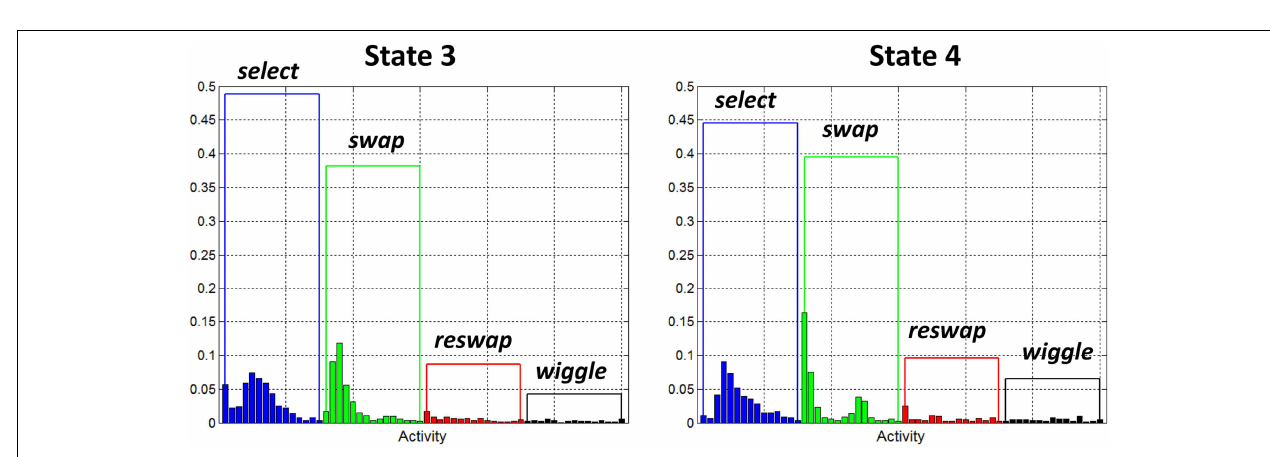
rules of the game, as demonstrated by the large probability assigned to the swap activities, and relatively small probabilities assigned to reswaps